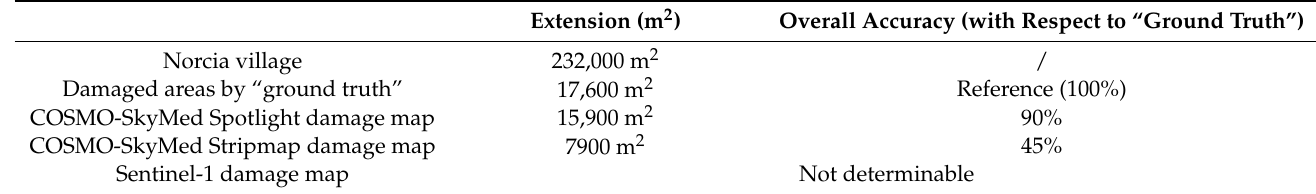
Figure 6. Cross-check among field surveys, COSMO-SkyMed Spotlight, and StripMap results. The white dotted line is the perimeter of the Norcia ancient walls used for the quantitative evaluation of the damage map reported in Table 4. Table 4. Quantitative evaluation of damage map in Figure 5.